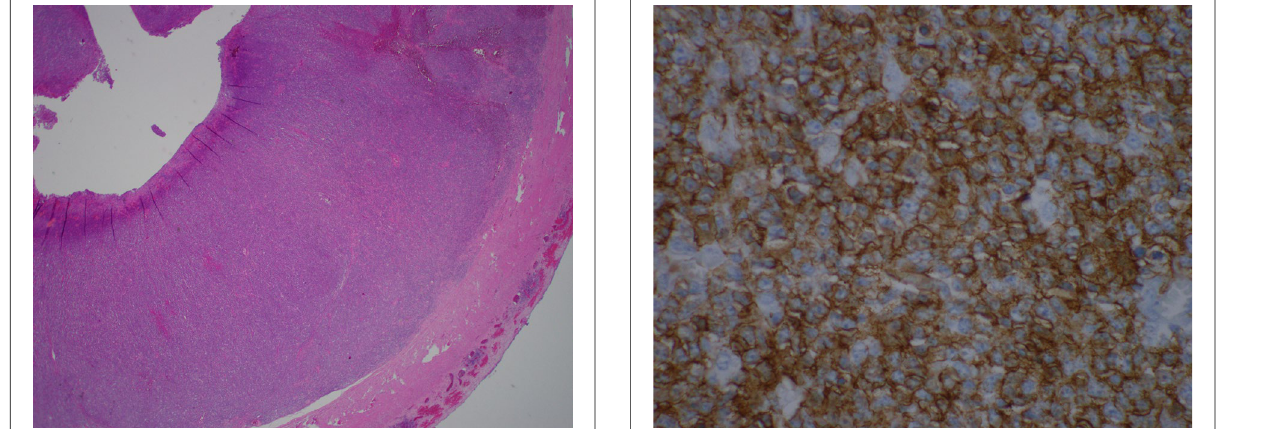
Fig. 3 Hematoxylin and eosin staining of appendiceal tissue demonstrating significant lymphoid invasion (